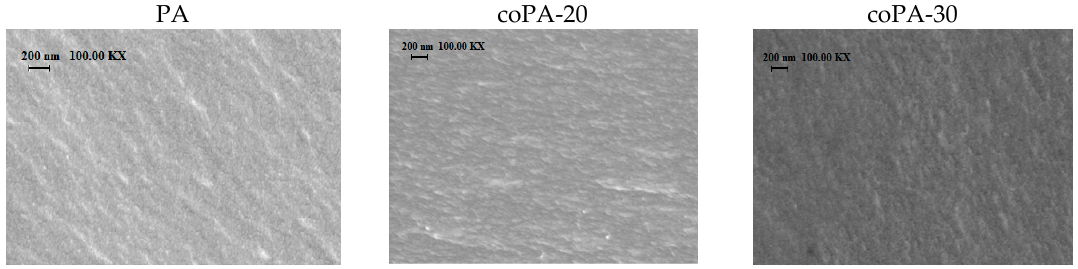
Figure 3. Scanning electron microscopy (SEM) micrographs of cross-section of PA, coPA-20, and coPA-30